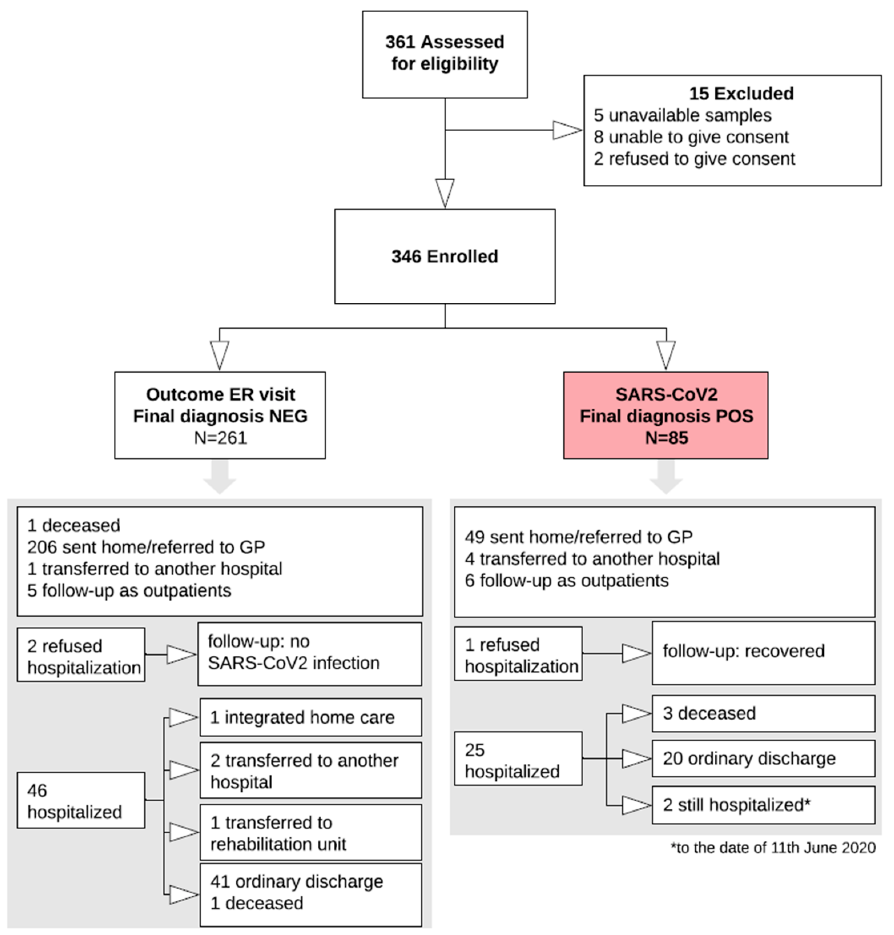
Figure 1. Study Flow chart. The white arrows indicate the study flow, up to the final classification of 85 subjects with the infection (red box) and 261 without the infection. The two grey arrows point to the two boxes resuming all the available details and outcomes of the two groups. ER, emergency room; NEG, negative; POS, positive; GP, general practitioner.